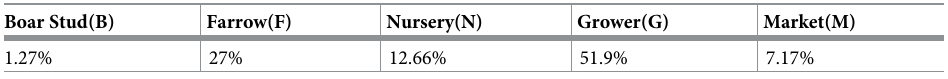
Table 3. Pig operation type